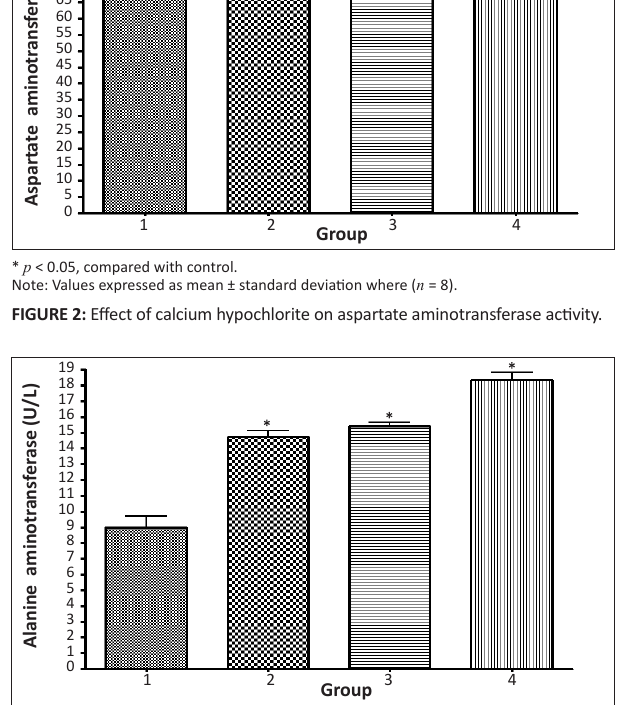
Figure 3: Effect of calcium hypochlorite on alanine aminotransferase (ALT) activity * p < 0.05, compared with control. Note: Values expressed as mean ± standard deviation where ( n = 8). Values expressed as mean ± S.D where ( n = 8). Asterisks indicate significant ( p <0.05) difference compared with control. FIGURE 3: Effect of calcium hypochlorite on alanine aminotransferase